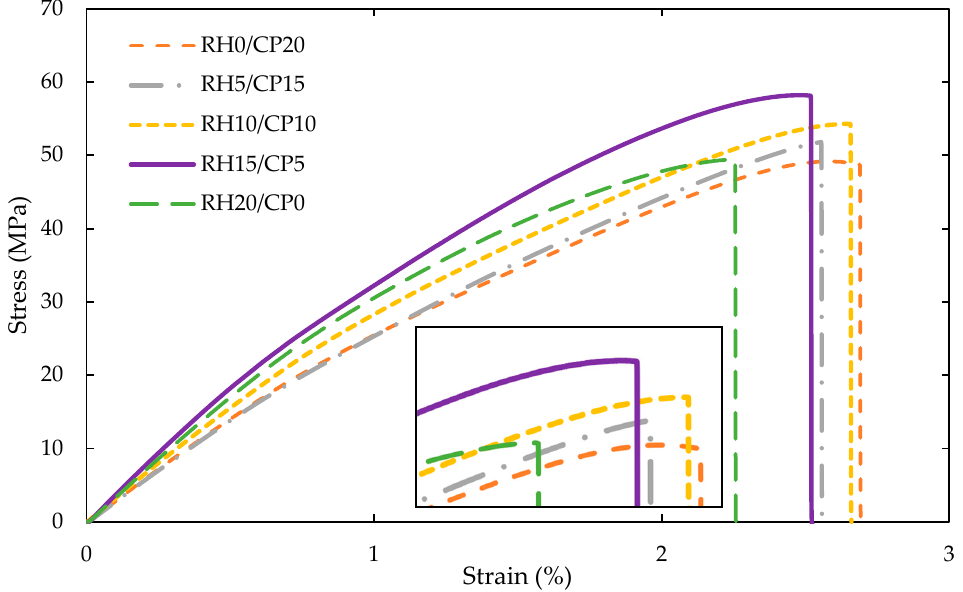
Figure 4. Typical stress-strain curves of RH/CP reinforced ABS blend composites.